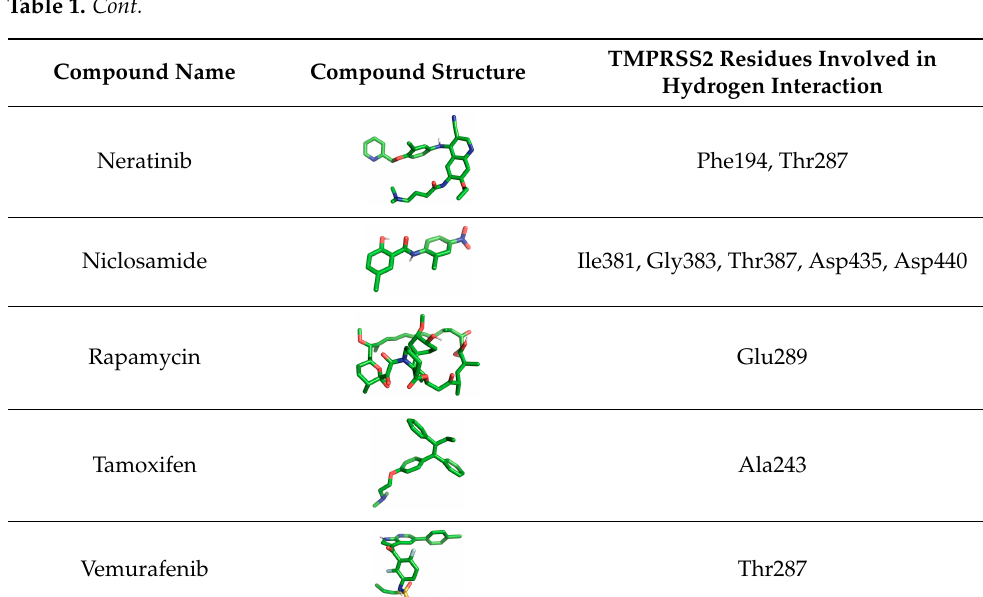
Table 2. Docking affinity for PL pro and molecular structure of individual compounds.